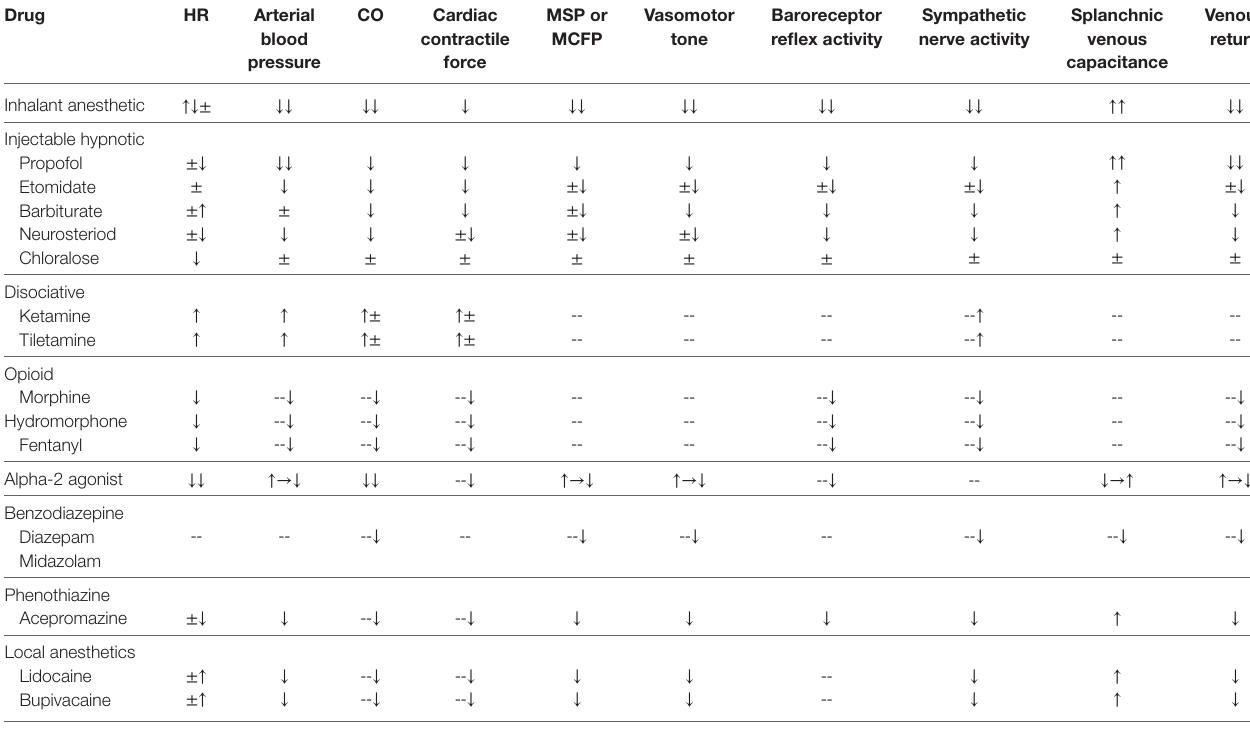
tAbLe 2 | Pharmacologic effects of clinically relevant doses of commonly administered anesthetic drugs. a